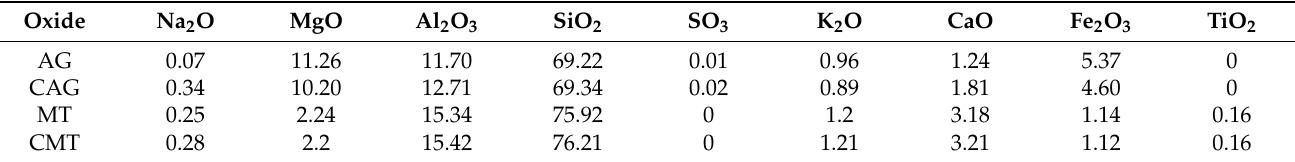
Table 4. Chemical fractions of attapulgite and montmorillonite before and after calcination (mass